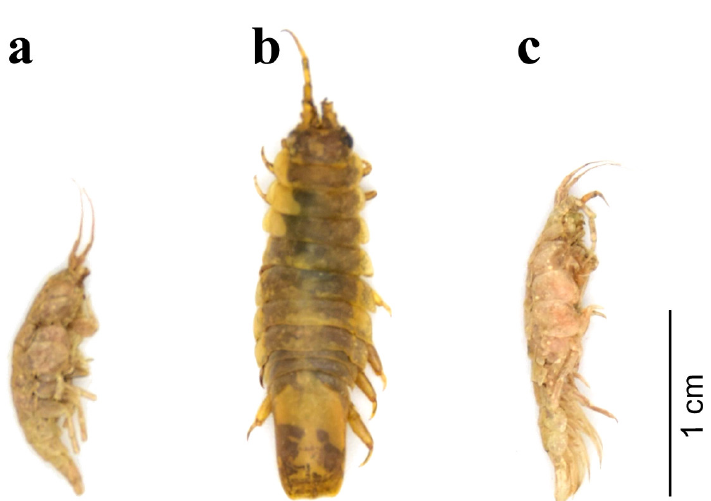
Figure 4. Morphology of the collected epizoans: ( a ) Apohyale sp.; ( b ) Idotea metallica ; ( c ) Peramphithoe tea .